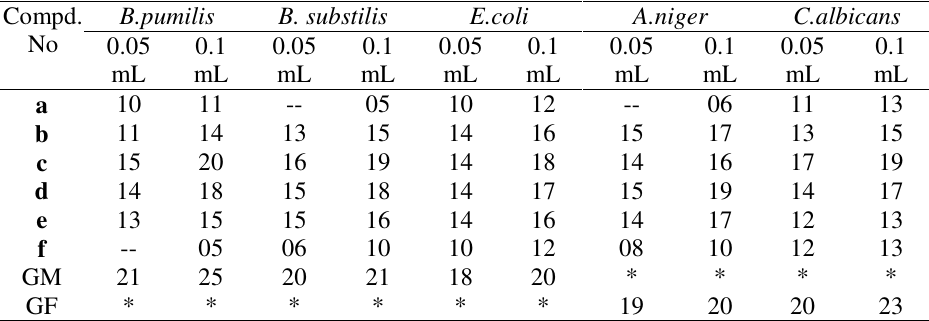
Table 3. Zone of inhibition of compound ( a-f